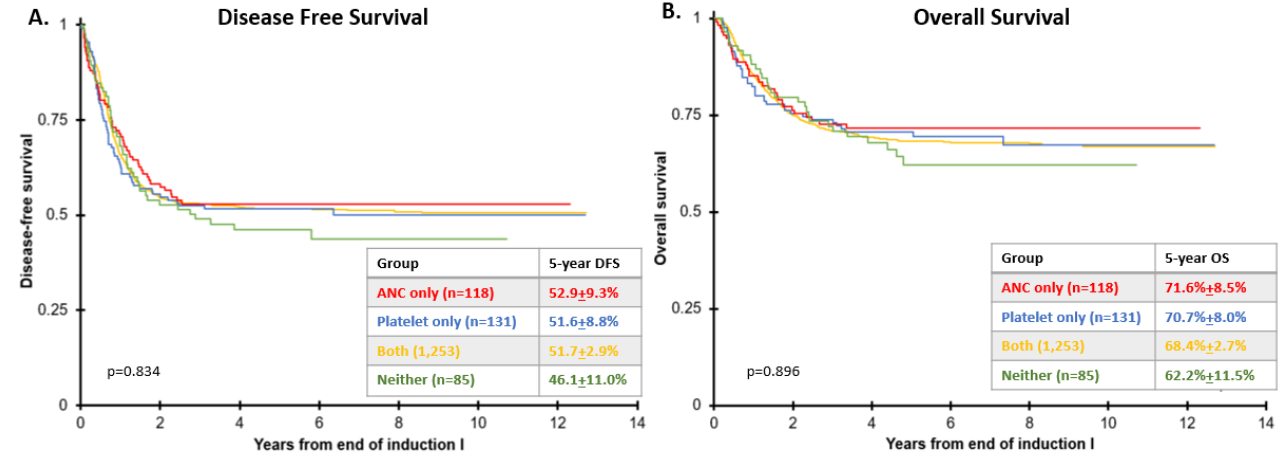
Figure 3. Survival by count recovery from end of induction I (EOI1). ( A ) Disease-free survival (DFS) and ( B ) overall survival (OS) from EOI1 are reported according to count recovery parameters in patients with <5% bone marrow blasts by central Δ N flow cytometry who received Induction I and II therapy in AAML0531 and AAML1031.